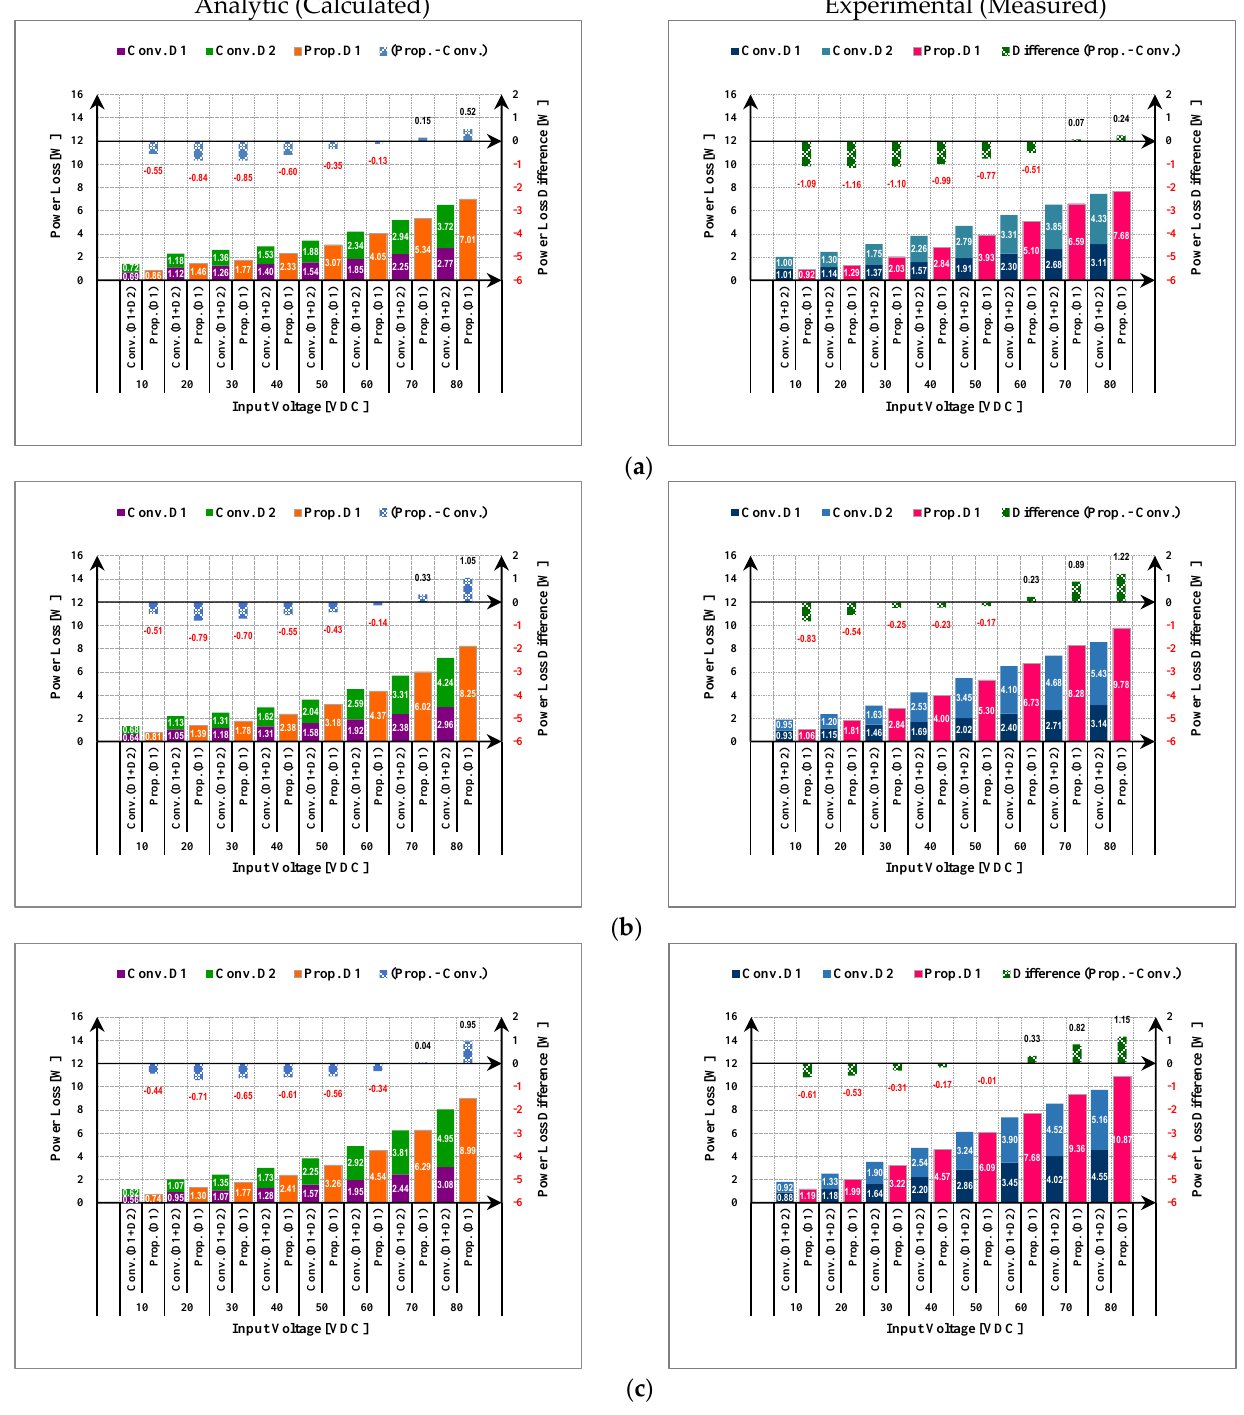
Figure 13. Analytic and experimental diode power loss of the buck-boost topology step-up period in the CC mode: ( a ) Duty = 0.556, I O = 0.8 A; ( b ) Duty = 0.571, I O = 0.75 A; and ( c ) Duty = 0.600, I O = 0.667 A.